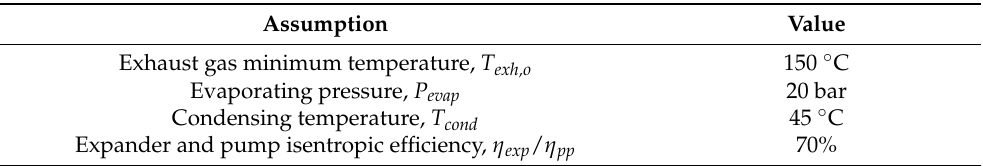
Table 10. Assumptions for ORC designs.